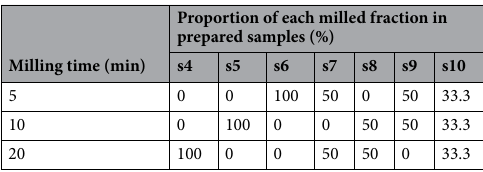
is related to the decrease in total porosity of a pore space following the same dependence as in the KC modeling approach. The absolute and relative values of these errors are presented together with estimated K sat values in Table 1. The error due to numerical mesh total porosity underestimation introduced via K sat estimation using the NS approach was in the range of 4.6–19% of the estimated K sat value. The error was on the average 10% for analyzed samples. The relative error seem to be higher for fine grained samples. The lowest values of the relative error was achieved for samples prepared from coarsest sand material. Technical aspects of simulation and modeling. Table 1 also provides information about the generated numerical meshes and pore networks. The generation of the NS meshes and PN networks was the most compu- tationally demanding task in this study. A multicore workstation with 512 GB RAM was used for this purpose. The size of the RAM was a limiting parameter that prevented the generation of more detailed NS meshes. The NS meshes that were generated consisted of 20 million cells in the case of the simplest pore space geometries and up to almost 90 million cells in the case of the samples with the highest specific surface. The files containing NS meshes have sizes ranging from ~ 3.5 to 11.5 GB. NS mesh generation using parallel mesh generation software took anywhere from five to 55 h. Pore network generation took a similarly long time, from 10 to 30 h each. Pore network generation time was substantially shortened from initial runs by parallelization of the initial ball search- ing step of the original 17 pore network generation code. Compared to the NS mesh and PN network generation